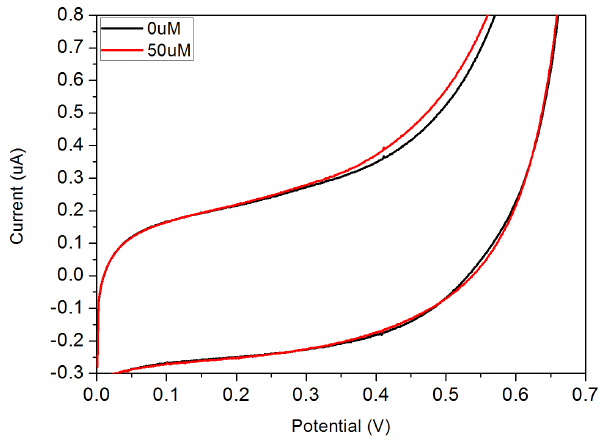
Figure 2. Cyclic-voltammagrams of the disposable biosensor showing the background current and the response current for a 50 µM solution using the disposable